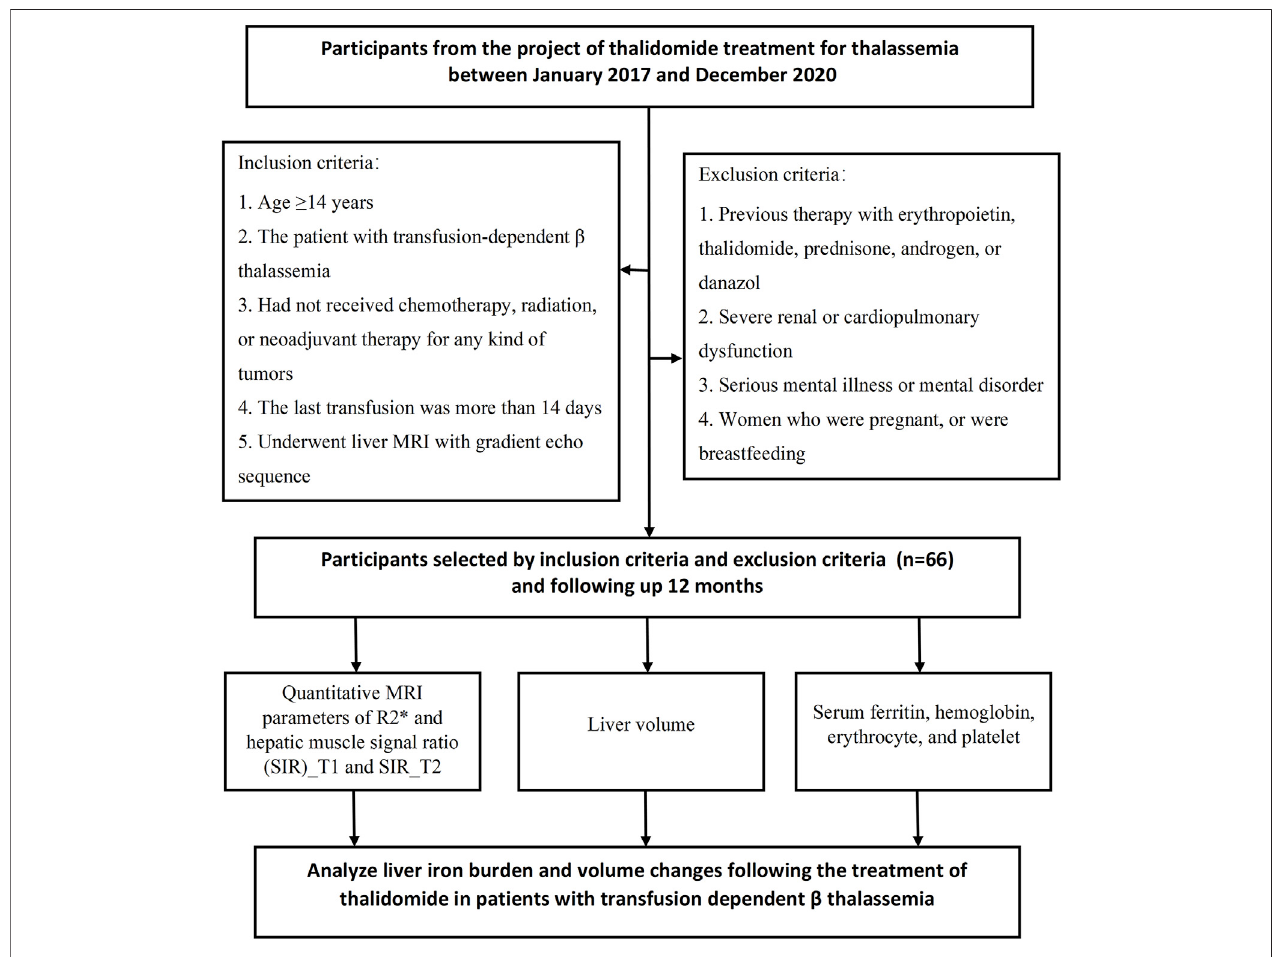
FIGURE 1 | Flowchart of the prospective study cohort. A total of 66 participants were included in this study.